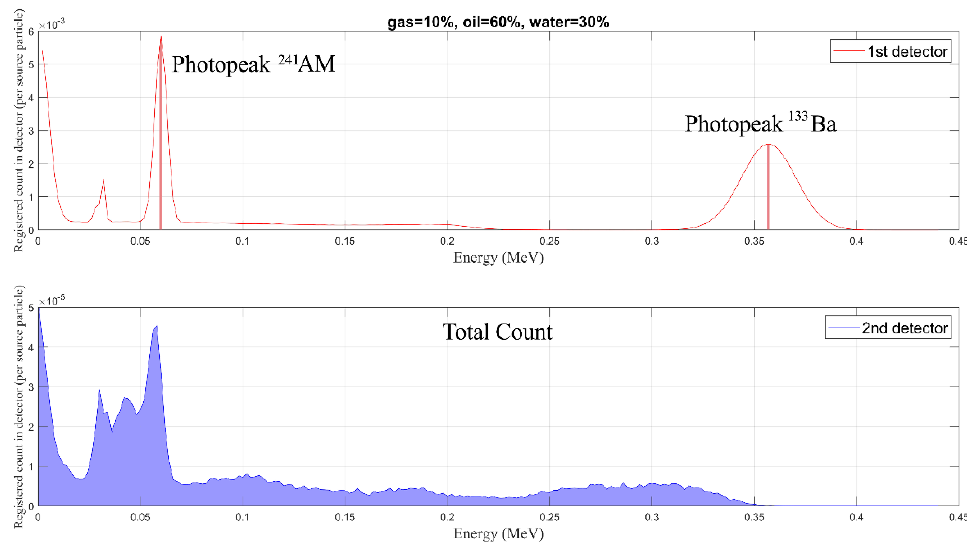
Figure 2. Features extracted from the signals received by two detectors.